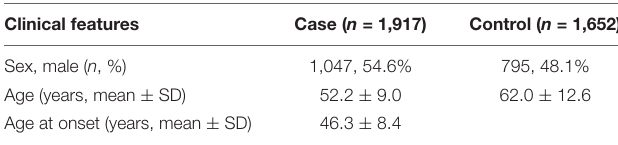
TABLE 1 | Demographic data of the study